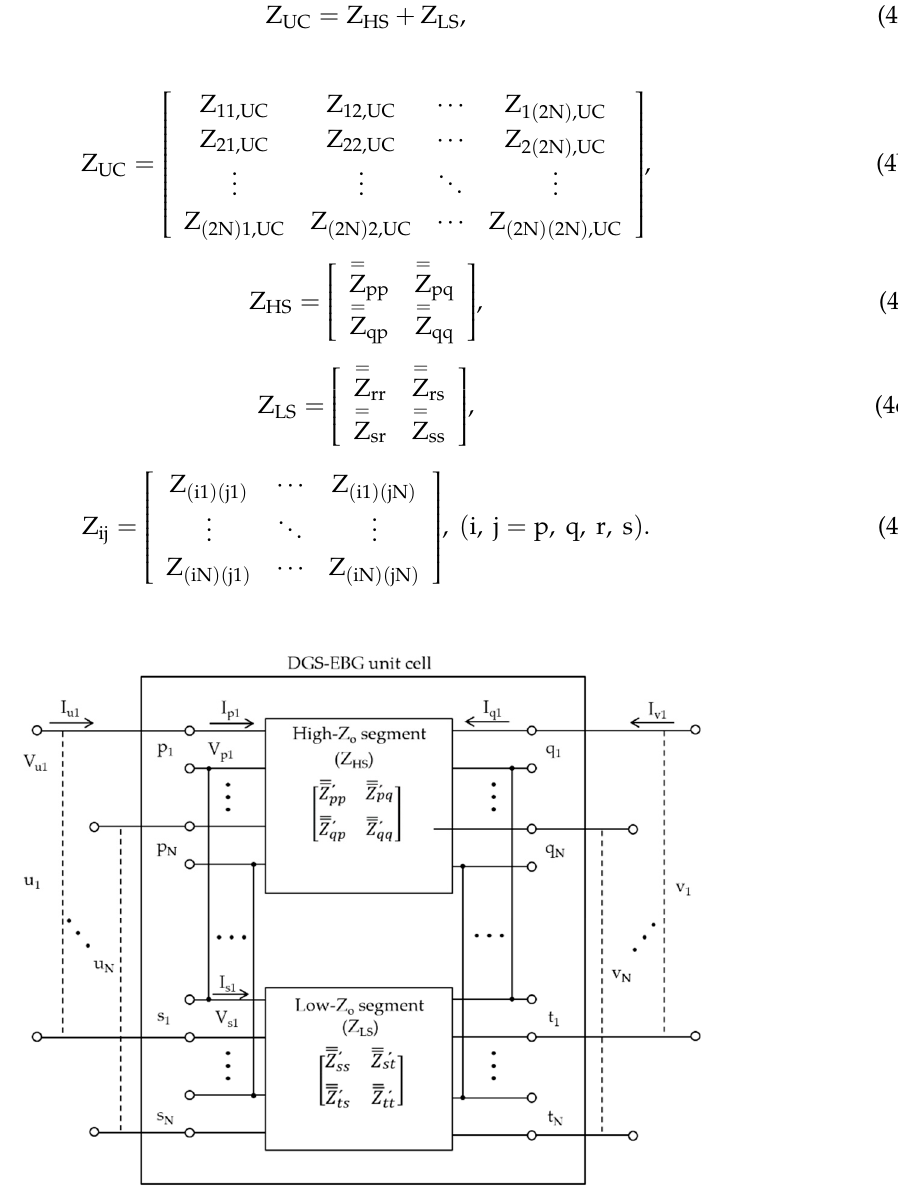
Figure 6. Impedance diagram (Z UC ) for DGS–EBG unit cell, high- and low-Z o segments. The high-Z o segment consists of a narrow plane connected to the wide plane through the via, as